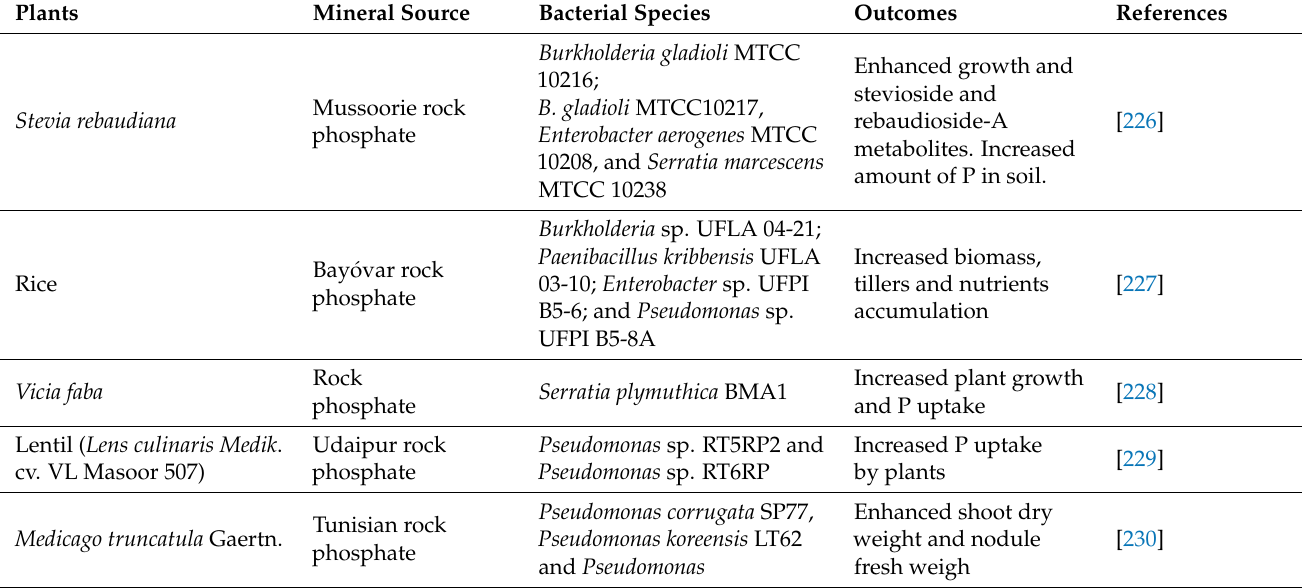
Table 5. Inoculation of phosphorus-solubilizing bacteria (PSB) on crop plants from different mineral